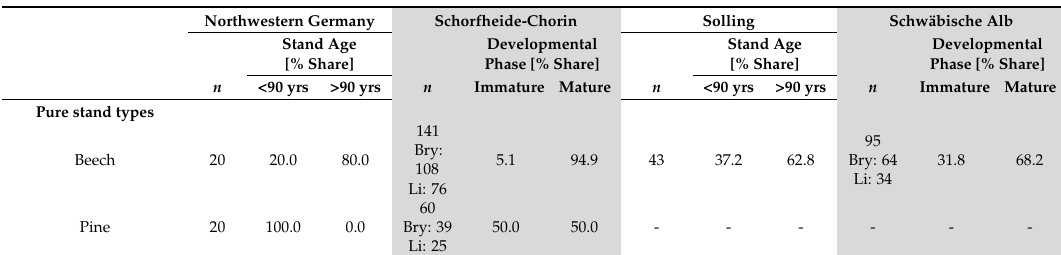
Table A1. Number of 400 m 2 plots ( n ) for the analyses of vascular plants for the study regions and stand types. For mixed stands, also the plot distribution across dominance classes of beech or conifer dominance or an equal share of both species on accumulated tree layer cover is given. For the regions Schorfheide-Chorin and Schwäbische Alb bryophytes (Bry) and lichens (Li) were sampled in a smaller subset of vegetation survey plots. Also given is the share of plots younger or older than 90 years for Northwestern Germany and Solling [42,43] and the share of plots representing the immature (dbh > 15 ≤ 30 cm) and mature (dbh > 30 cm) developmental phase in Schorfheide-Chorin and Schwäbische Alb